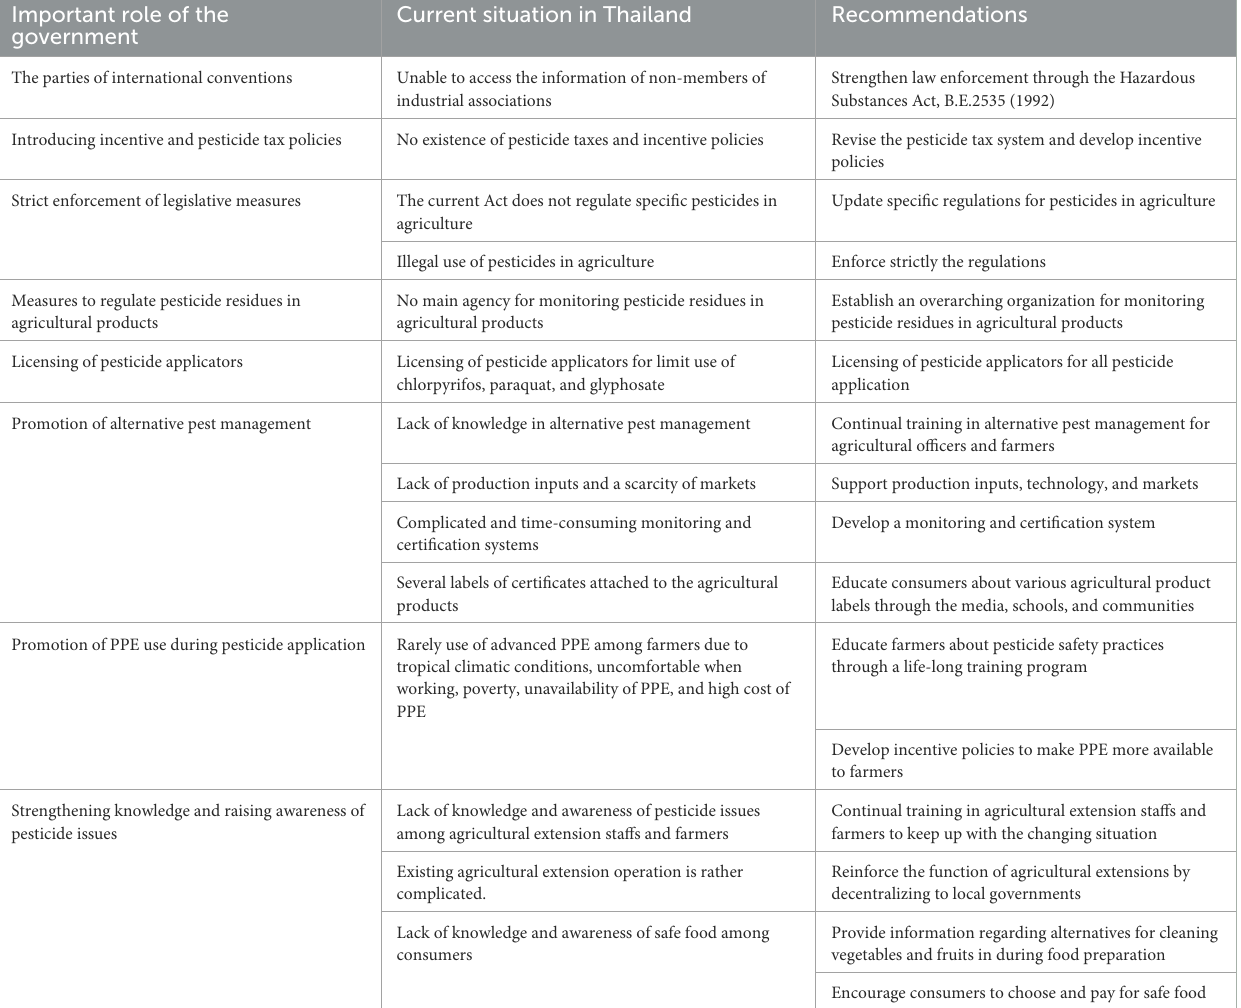
TABLE 1 Important role of Thailand’s government: Current situation and